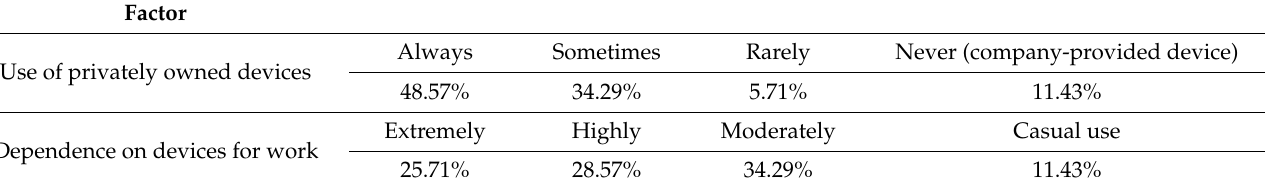
Table 3. Reliance on mobile devices engaged in BYOD initiatives.